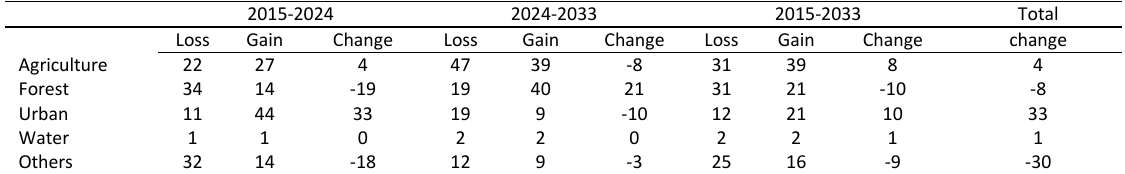
Fig. 6: The future simulated changes in land use of the Selangor River basin in 2024 and 2033 Table 3: Total predicted change (%) of each type of land use in the different periods Table 3: Total predicted change (%) of each type of land use in the different